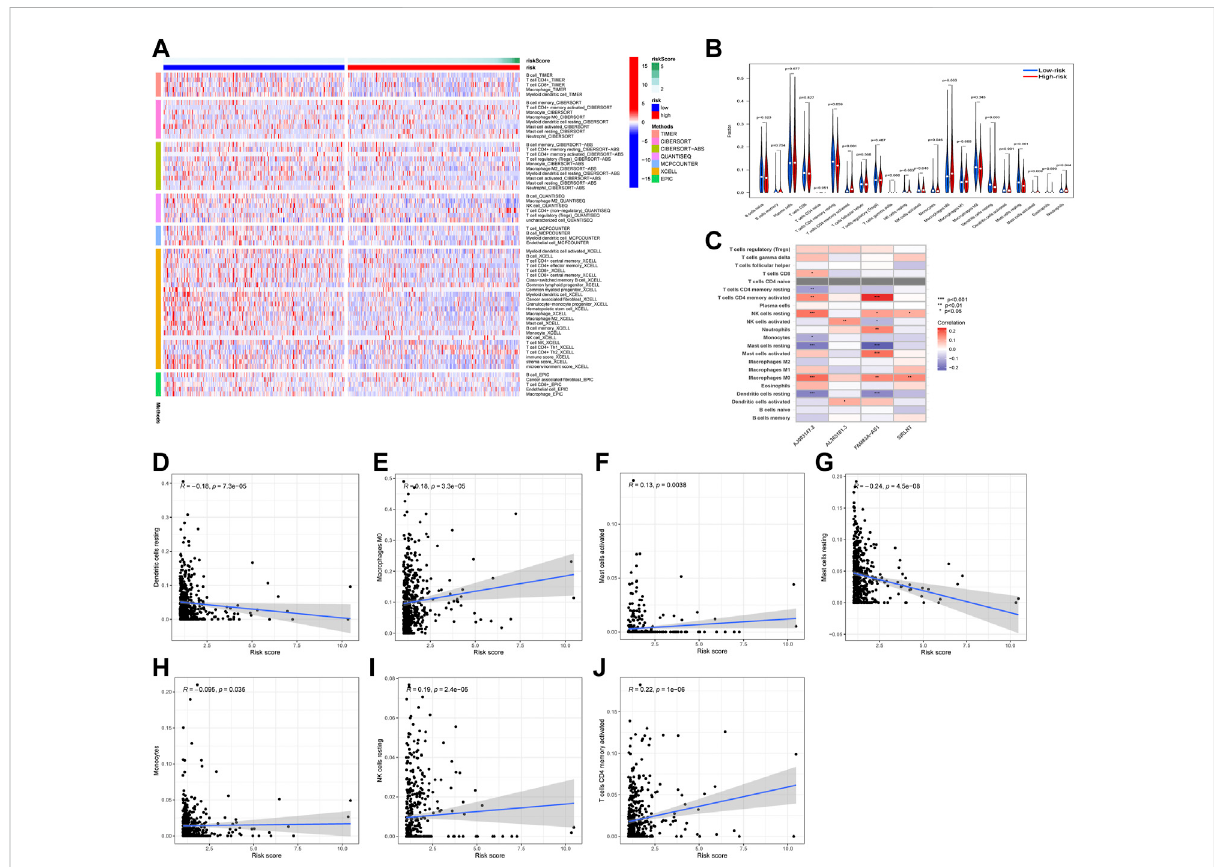
FIGURE 7 Analysis of immune cell in fi ltration. The immune landscapes of high-risk and low-risk groups (A) . The difference of immune cell between high- risk and low-risk groups (B) . The association of 4 NETs-associated lncRNAs expression and immune cell in fi ltration (C) . The association of risk score and immune cell in fi ltration (D – J) (* p < 0.05, ** p < 0.01, *** p <